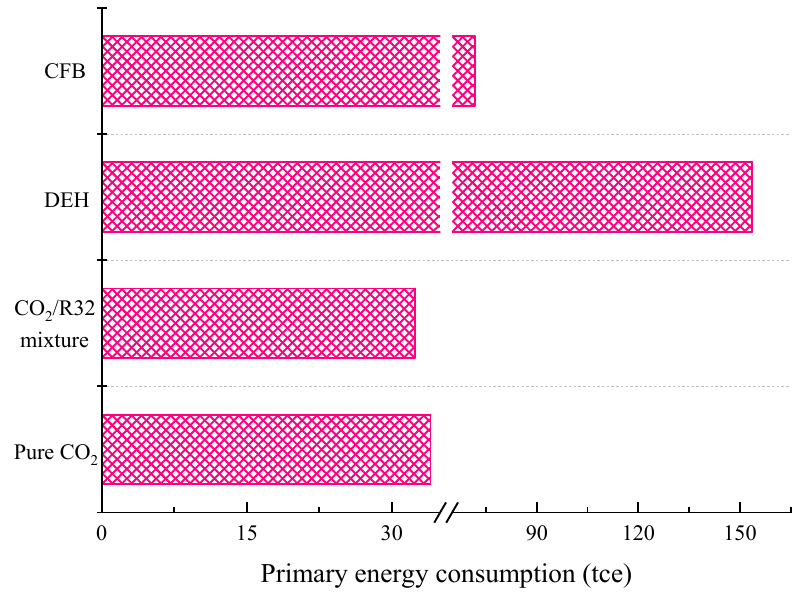
Figure 15. Comparison of the primary energy consumption.